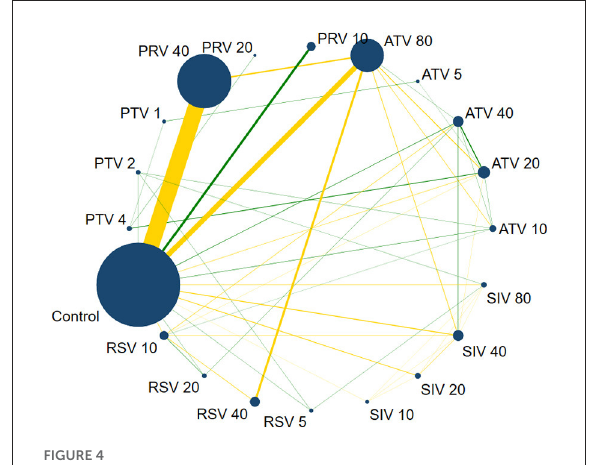
FIGURE4 Network evidence plot on CRP. The size of nodes is directly proportional to the number of studies. The lines link two direct-comparison interventions, their thickness is proportional to the number of comparisons, and the green links represent at least one double-blind comparison. PTV 4: Pitavastatin 4 mg/d; PTV 2: Pitavastatin 2 mg/d; PTV 1: Pitavastatin 1 mg/d; PRV 40: Pravastatin 40 mg/d; PRV 20: Pravastatin 20 mg/d; PRV 10: Pravastatin 10 mg/d; ATV 80: Atorvastatin 80 mg/d; ATV 5: Atorvastatin 5 mg/d; ATV 40: Atorvastatin 40 mg/d; ATV 20: Atorvastatin 20 mg/d; ATV 10: Atorvastatin 10 mg/d; SIV